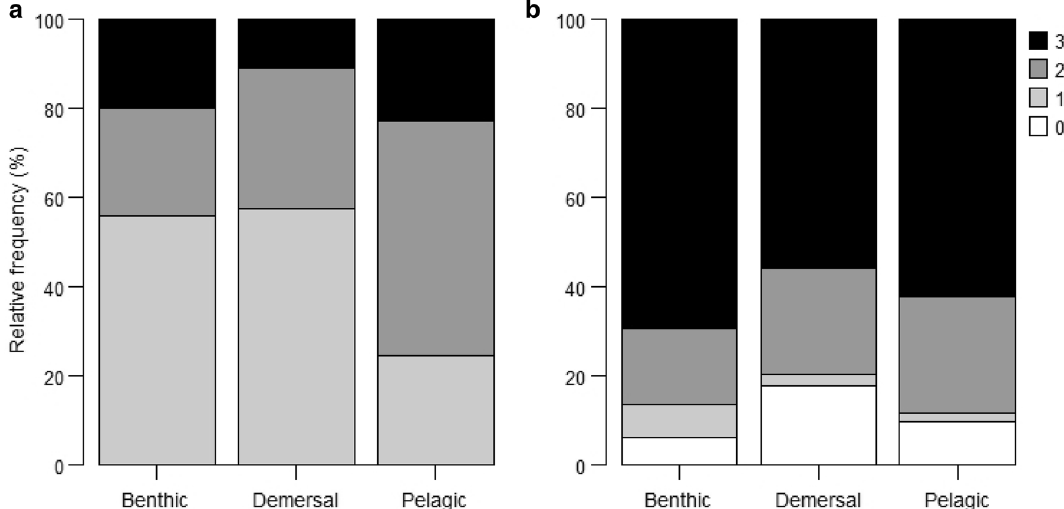
Figure 5. Data quality of ( a ) climate exposure factors and ( b ) sensitivity attributes per group of key fishery resources in the Northern Humboldt Current System. Data quality score: 3) High quality data; 2) Related data; 1) Reviewer judgement; 0) No